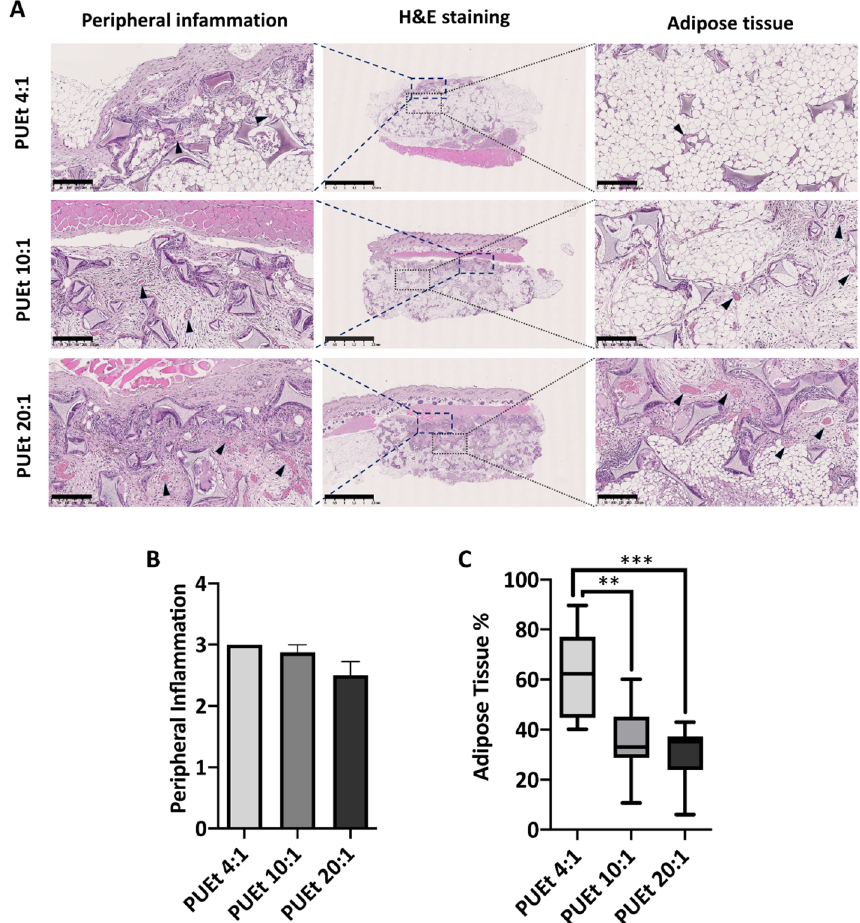
Figure 2. ( A ) representative H&E stained histological images of PUEt 4:1, PUEt 10:1, and PUEt 20:1. In the middle: low-magnitude images showing the entire explanted scaffolds after 3 months of subcutaneous implantation. Subregions were selected to show peripheral inflammation and adipose tissue (dashed blue and dotted gray, respectively) (scale bar, 2.5 mm). Left and right columns display higher magnification images representing the peripheral inflammation and adipose tissue in each group, respectively. Vascular tissue is indicated by black arrowheads, scale bar = 250 µm. ( B ) graphical representation of peripheral inflammation of the 3 groups: PUEt 4:1, PUEt 10:1, and PUEt 20:1 (scoring system described in paragraph 4.12, Table 4 and Table S2). No significant difference between the three groups was found, in terms of peripheral inflammation. ( C ) Graphical representation of the adipose tissue % for the 3 groups: PUEt 4:1, PUEt 10:1, and PUEt 20:1. The semi-quantification of adipose tissue % was carried out according to the method described in paragraph 4.14 and in Fig. 3. Statistically relevant differences in terms of % of adipose tissue was found between PUEt 4:1 vs PUEt 10:1 (** p < 0.025) and PUEt 4:1 vs PUEt 20:1 (*** p <